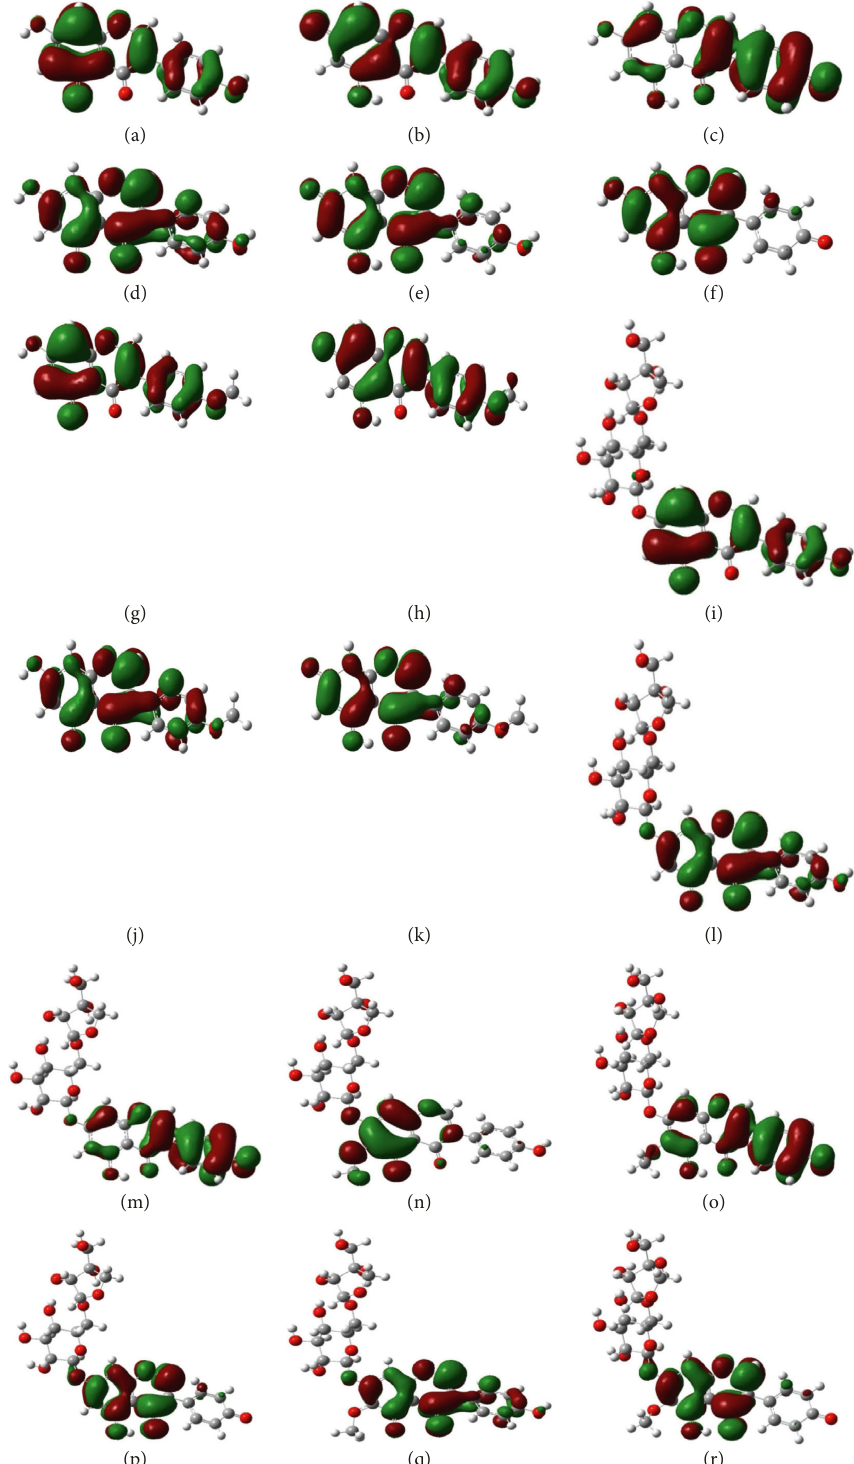
Figure 6: HOMO and LUMO of structural radicals 1–4 . (a) HOMO-5-OH radical ( 1 ). (b) HOMO-7-OH radical ( 1 ). (c) HOMO-4 radical ( 1 ). (d) LUMO-5-OH radical ( 1 ). (e) LUMO-7-OH radical ( 1 ). (f) LUMO-4 (h) HOMO-7-OH radical ( 2 ). (i) HOMO-5-OH radical ( 3 ). (j) LUMO-5-OH radical ( 2 ). (k) LUMO-7-OH radical ( 2 ). (l) LUMO-5-OH radical ( 3 ). (m) HOMO-4 -OH radical ( 3 ). (n) HOMO-5-OH radical ( 4 ). (o) HOMO-4 LUMO-5-OH radical ( 4 ). (r) LUMO-4 -OH radical ( 4 ′ ′